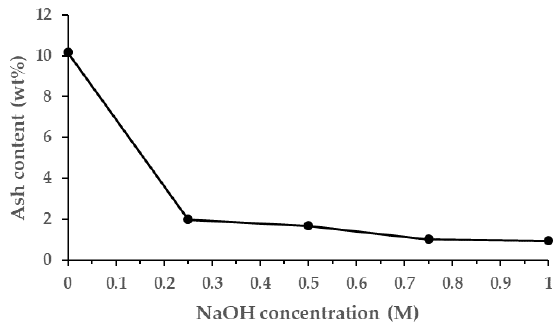
Figure 2. Variations on the ash contents of pretreated RH samples.